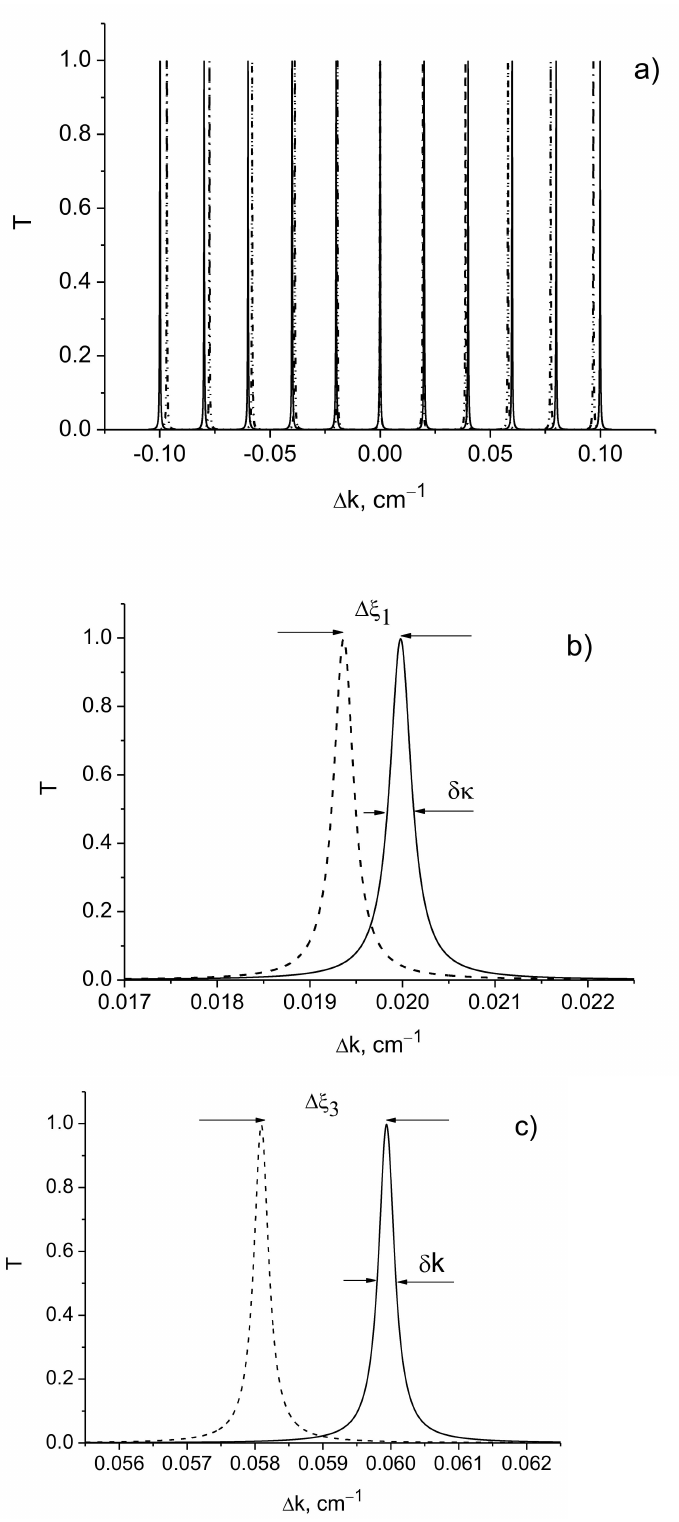
Figure 2. Transmittance as function of detuning ∆ k . ( a ) A set of peaks from the two arms of the Mach– Zehnder interferometer with different distances between the mirrors; ( b ) the peaks corresponding to the 1st order modes; ( c ) the peaks corresponding to the 3rd order modes. d = 100 π cm, L = 0.75 cm, λ = 630